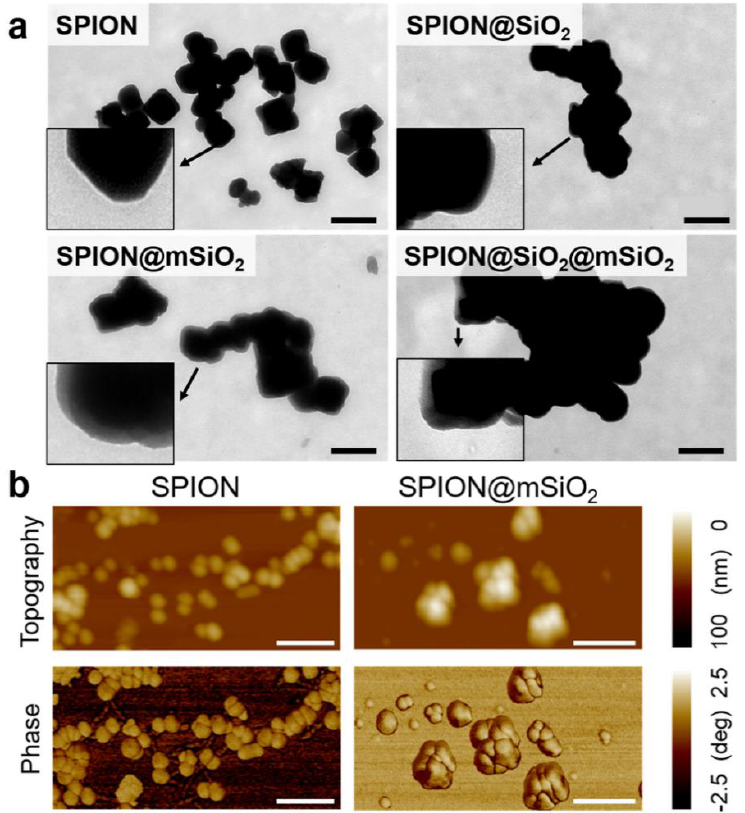
Figure 3. Transmission electron microscopy (TEM) images of the nanoparticles (scale bar = 300 nm, inserts show SPIONs at higher magnification) ( a ) and atomic force microscopy (AFM) topographical and phase images of SPIONs and SPION@mSiO 2 (scale bar = 200 nm) ( b ).